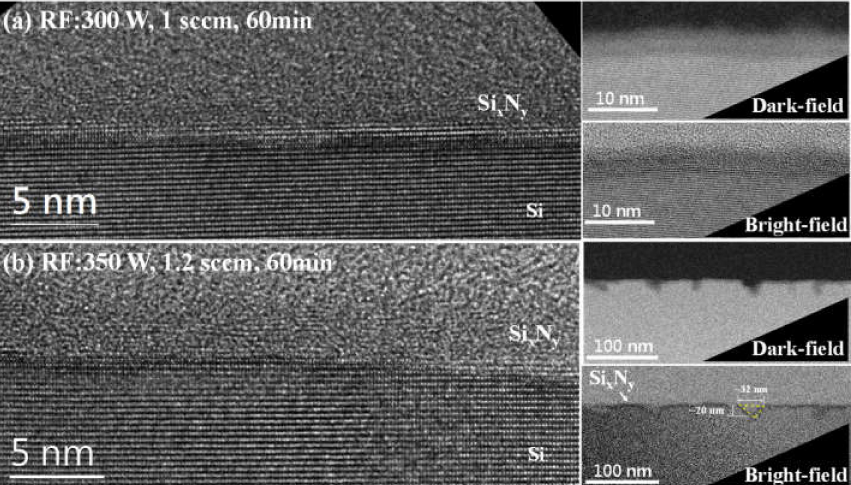
Figure 4. Bright field XTEM images of nitrided Si x N y /Si(111) surface for 60 min with ( a ) RF: 300 W, N 2 : ~1 sccm, and ( b ) RF: 350 W, N 2 : ~1.2